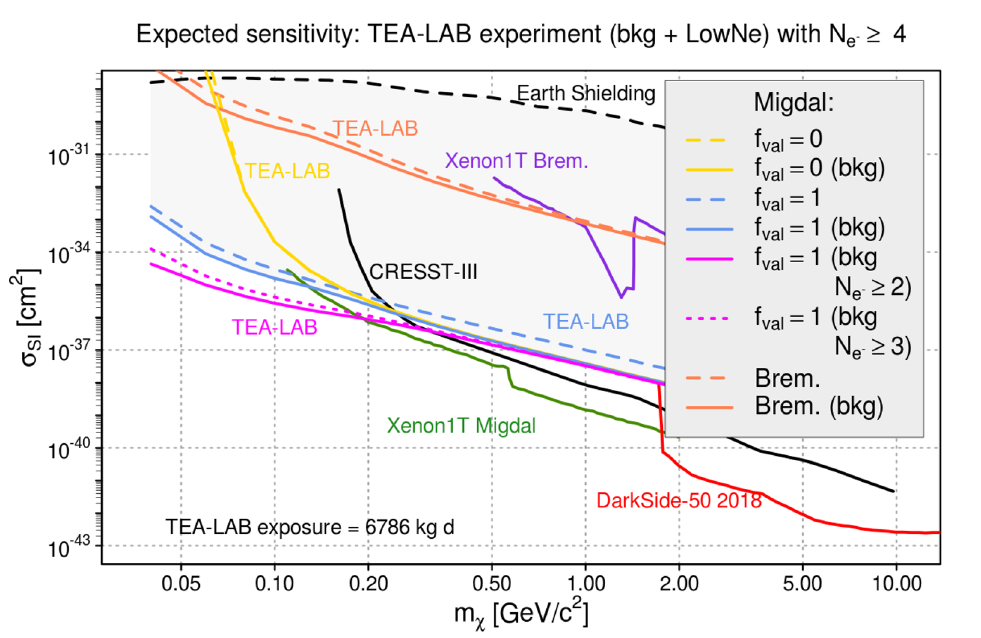
90% C : I : upper bounds on the (cid:27) SI exploiting the Migdal electron and photon Bremsstrahlung signals for the tea-lab simulated experiment loosely inspired by DarkSide-50. These results are obtained using and exposure E = 6786 kg d , and simulating a pseudo-dataset with the background-only template, including the LowNe excess (see section 3.2, 3.1). The tea- lab bounds are computed for a threshold N = 4 . The solid lines are obtained assigning the e (cid:0) LowNe excess to the background as explained in section 3.2.2, while the dashed lines give the limit in the default scenario where the excess is not accounted for as background. The impact of this effect is given for 2 different Migdal electron signal uncertainties (see section 3.2.2): f val = 0 corresponding to no valence shell contribution (yellow lines) and f val = 1 (blue lines). For f val = 1 we also show the result of considering N (cid:21) 2 (magenta solid line) and N (cid:21) 3 (magenta dotted e (cid:0) e (cid:0) line), with the excess accounted for as background. The estimate of the Earth shielding effect for tea-lab is also reported (black dashed curve). The gray shaded area, has to be intended as the region where tea-lab has the sensitivity to exclude a DM signal exploiting the Migdal